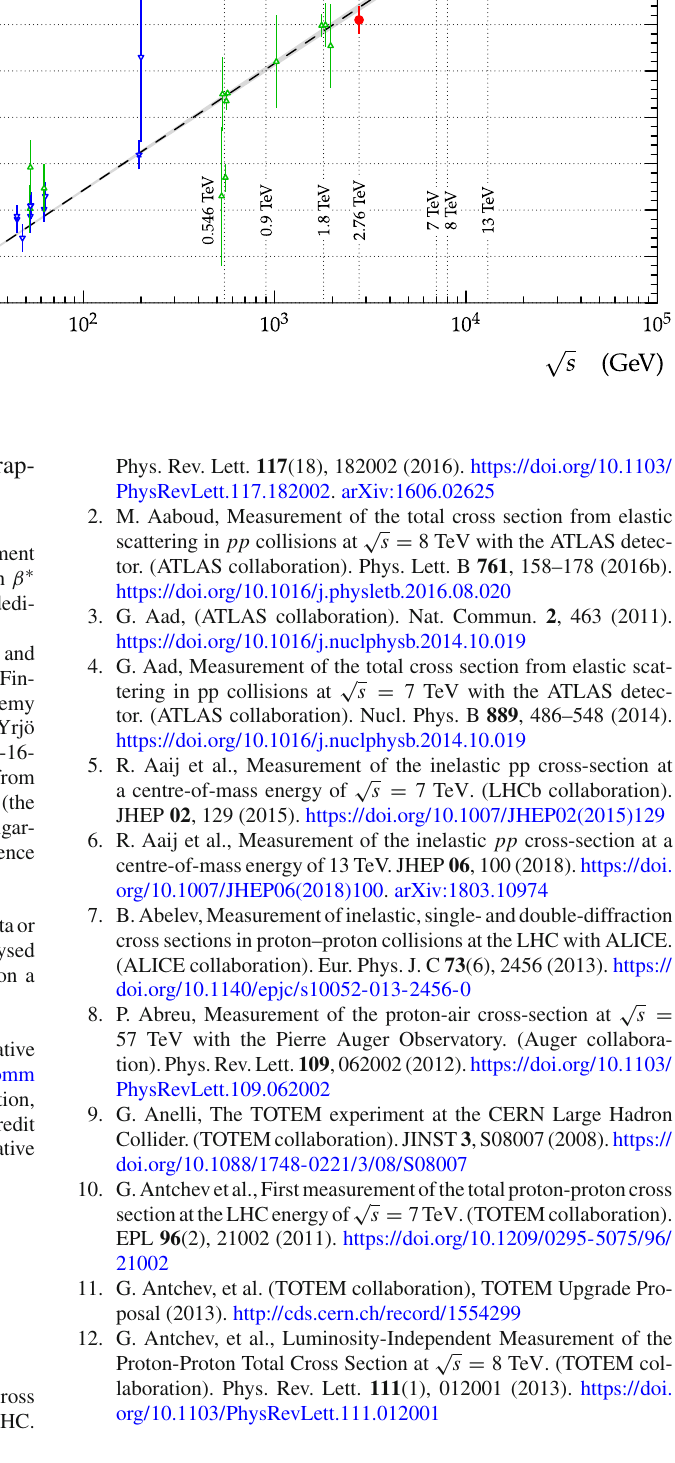
Fig. 7 The nuclear slope B for pp and p ¯ p elastic scattering as a √ s . It should be function of understood that while B is defined at t = 0, the experimental measurements are actually averaging the slope, hence they depend on the chosen t -range and on the deviations of the data from a pure exponential. While fluctuations beyond the experimental error bars should thus be expected, √ s > 3 TeV the deviation for from the linear extrapolation is highly significant [2,4,12,14,